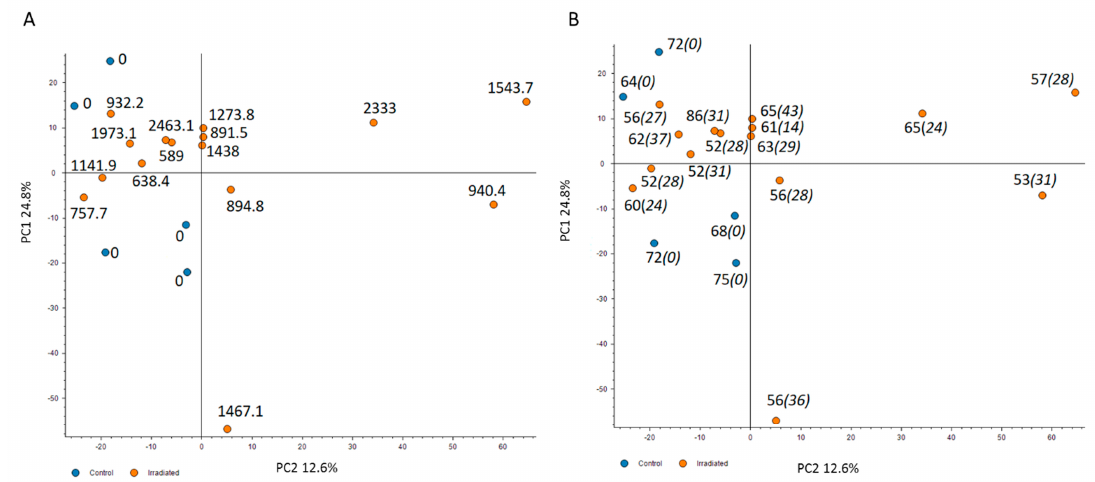
Figure 1. The principal component analysis (PCA) based on all proteomics features. The PCA used all features resulting in PC1 and PC2 as follows: PC1 24.8% and PC2 12.6%. The distribution of proteomics features is illustrated based on the dose (mGy) ( A ), the age (regular font) and the years of exposure (italics) ( B ). The control samples are presented as blue spots and the irradiated samples with the corresponding individual dose in orange. The analysis was performed using the Proteome Discoverer 2.3 software (Thermo Scientific, Waltham, MA, USA). Detailed information of the sample donors and the exact doses are given in Table S1.